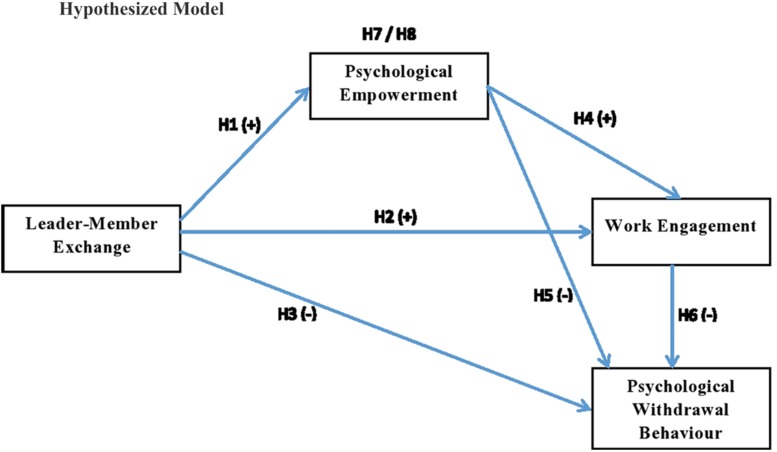
Hypothesized model.